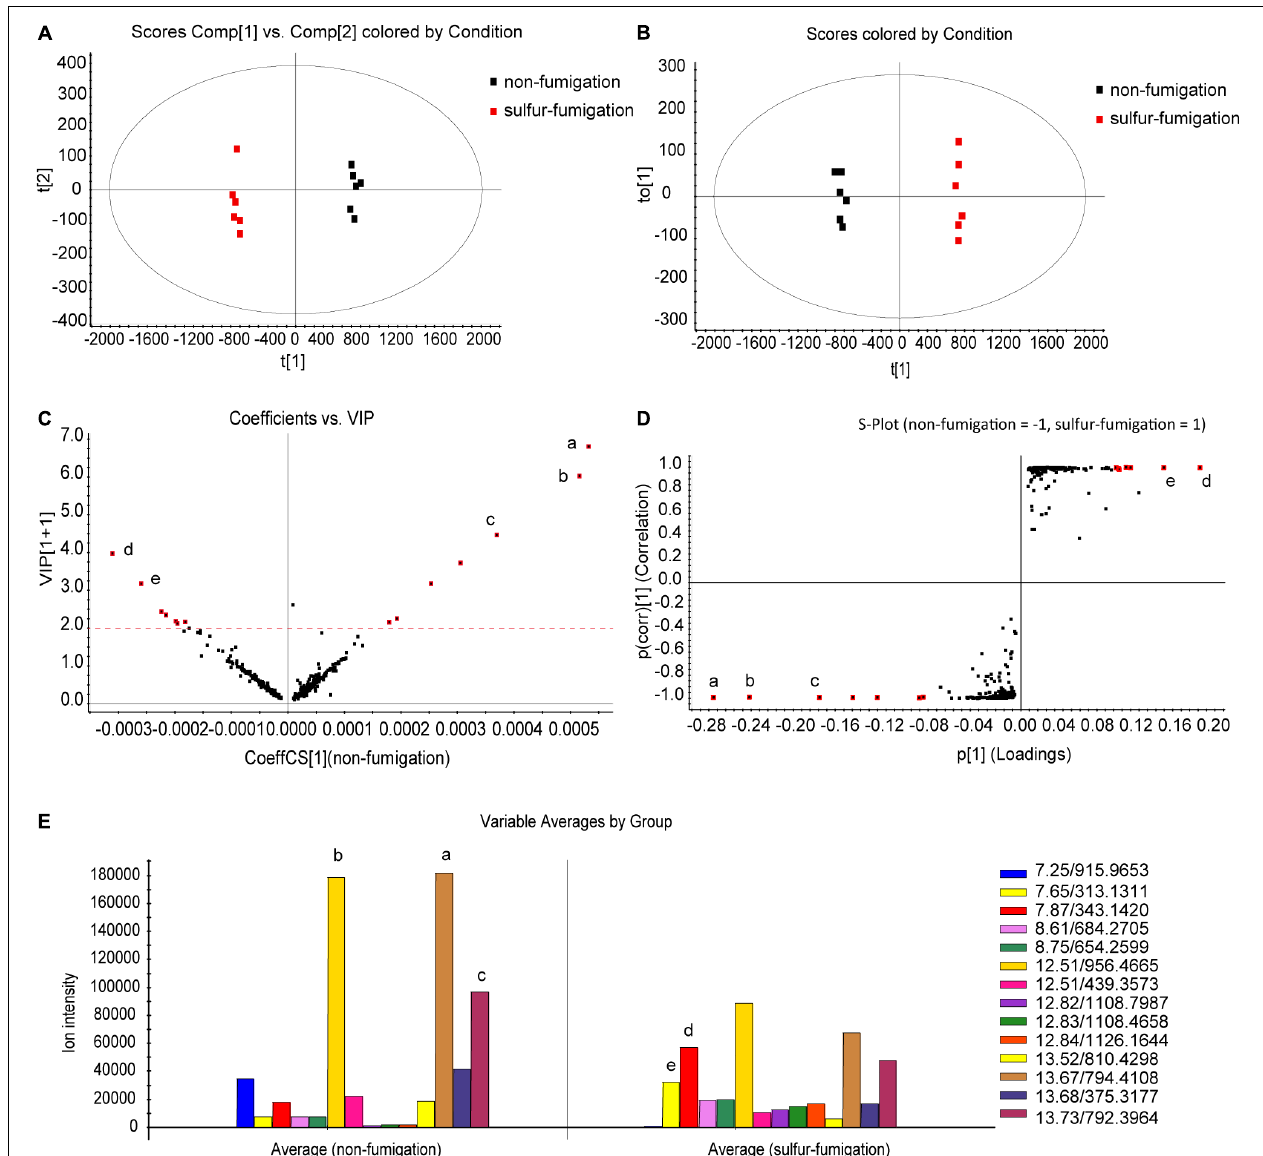
FIGURE 2 | Multivariate statistical analysis of methanol extracts of non-fumigated GR (0 h) and sulfur-fumigated AB (2 h) samples. (A) PCA/scores plot (six samples with each group, three biological replicates); (B) OPLS-DA/scores plot (six samples with each group, three biological replicates); (C) VIP plot; (D) S-plot; (E) column plot of the ion intensity (compounds a–e are significantly different markers in AB